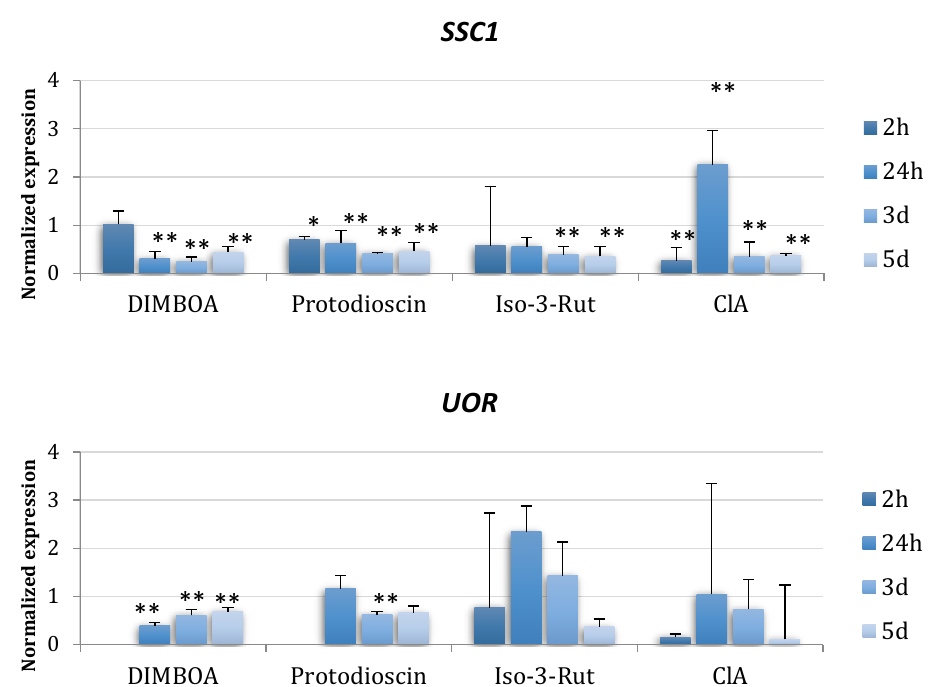
Figure 3. Changes in expression of the chosen primary metabolism-linked genes induced by the plant metabolites in liquid Fusarium proliferatum KF 3360 cultures after 2, 24, 72, and 120 h after metabolite addition. Average values of three replicates are shown. Differences statistically significant at * p < 0.05, ** p < 0.01, and standard deviations are shown.